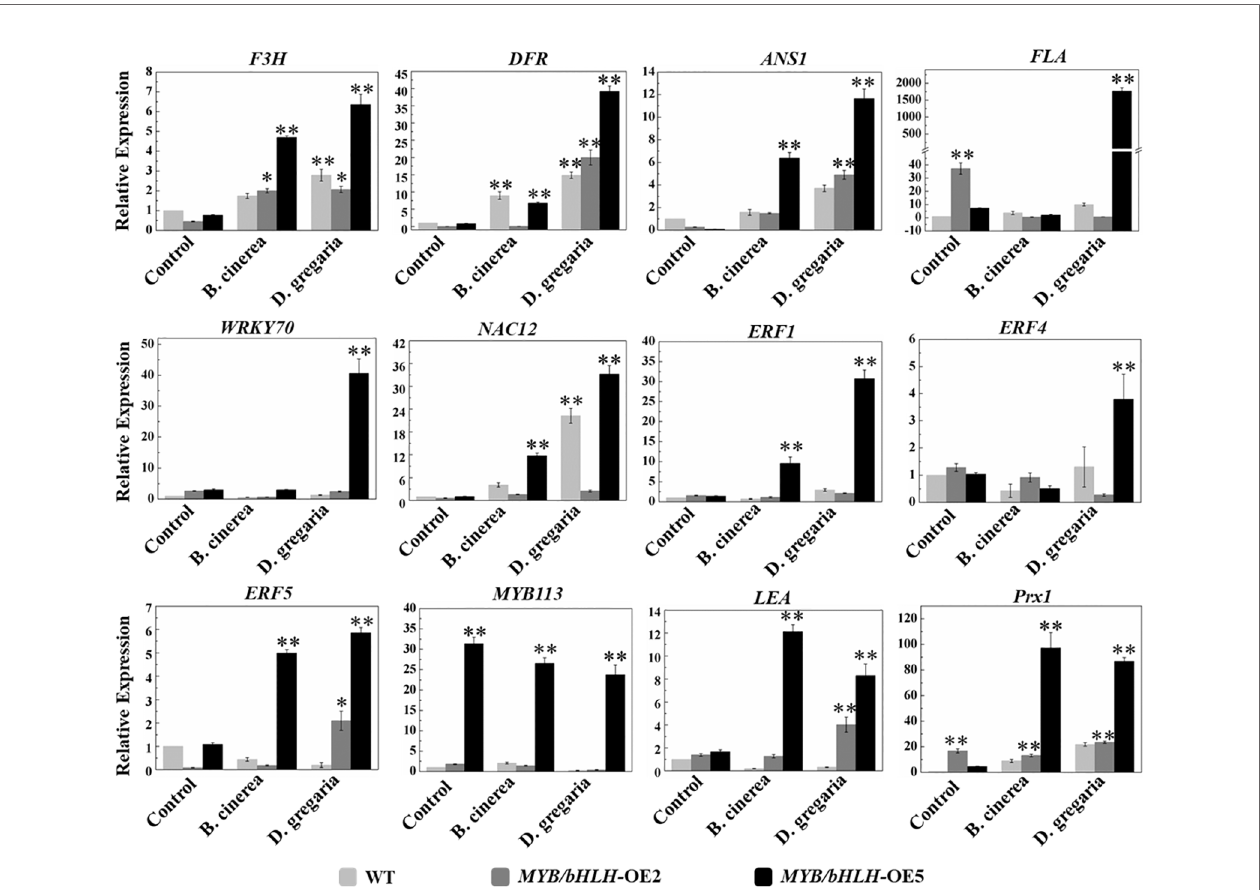
FIGURE 6 | Quantitative real-time PCR analysis of the transcript levels in WT and both independent MYB90 / bHLH1 -OE lines before and after being infected by two types of pathogens. The CYC063 expression was set as the internal control. In the fi gure, light gray bar represents WT, dark gray and black bars represent MYB90 / bHLH1 -OE2 and MYB90 / bHLH1 -OE5 lines, respectively. Each measurement was carried out in triplicate, and error bars represent the SE of the mean of fold changes for three biological replicates. Asterisks indicate signi fi cant differences: * P < 0.05, ** P ≤